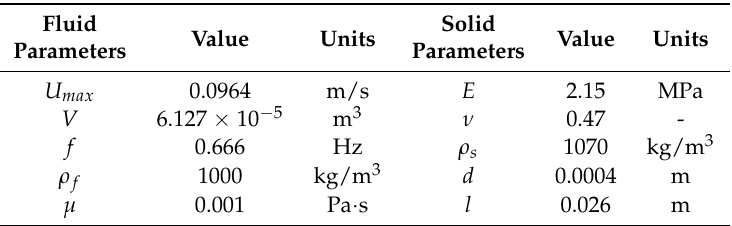
Table 1. List of parameters used for the FSI